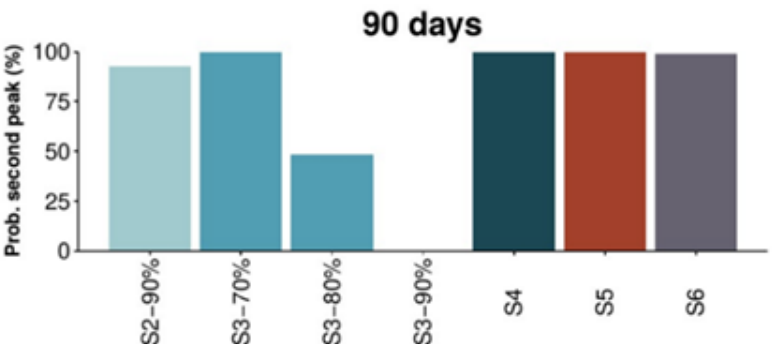
Figure 2. Probability of a second peak of the epidemic 60 days after measures are lifted [65]. Re- produced from [65].